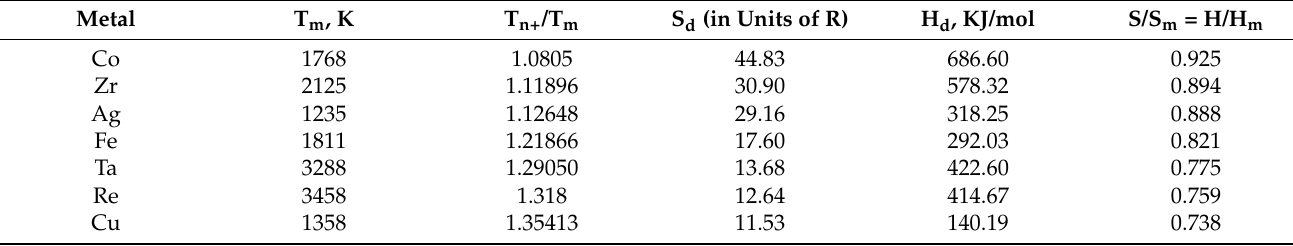
Table 5. Thermodynamic data for configurons in metals. T m the melting temperature in Kelvin; T n+ /T m the second melting temperature divided by T m ; S d the configuron entropy in units of R = 8.34 J; H d the configuron enthalpy in KJ/mol; S/S m = H/H m the ratio of the second melting entropy and S m equal to the ratio of the second melting enthalpy and H m